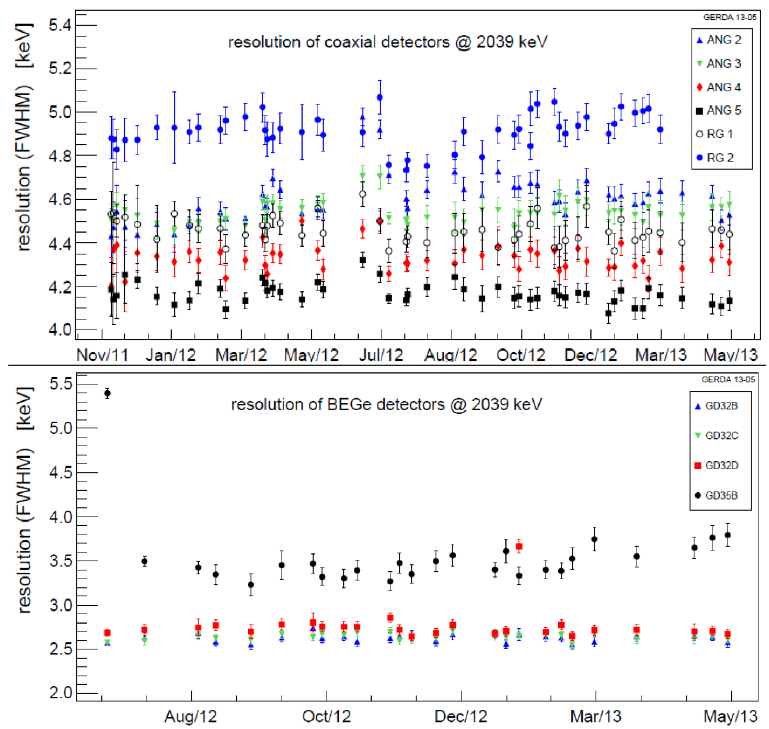
Figure 10. The G ERDA Phase I energy resolution at Q ββ as measured by the 228 Th calibrations Phase I series as a function of time for C OAX ( top ) and BEGe ( bottom ) detectors, respectively. For the C OAX s, the ANG detectors are the former H D M, while the RG are the former I GEX